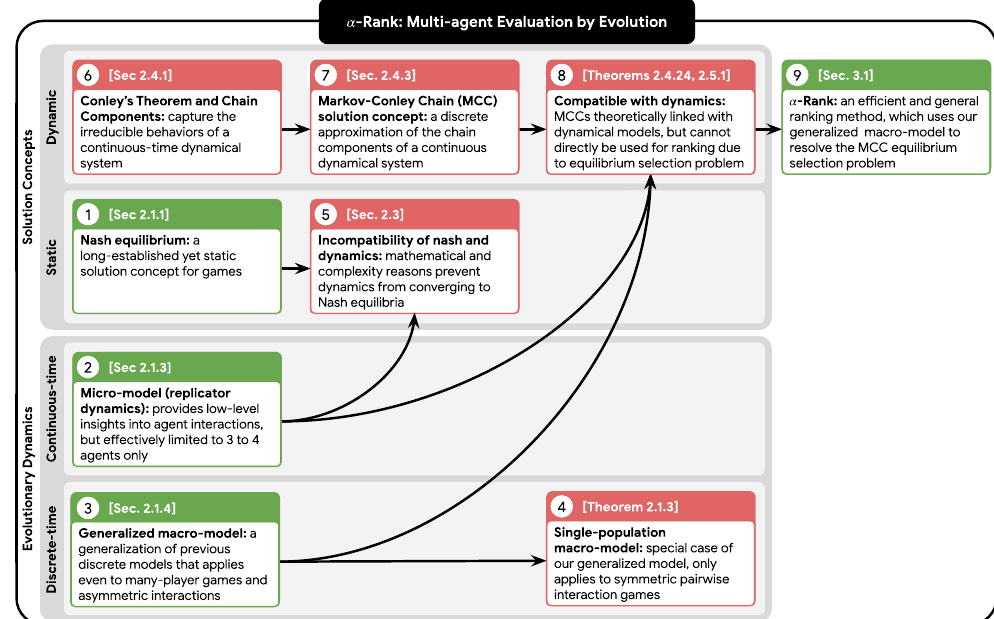
Figure 1. Paper at a glance. Numerical ordering of the concept boxes corresponds to the paper flow, with sections and/or theorems indicated where applicable. Due to the technical background necessary for fully understanding the paper contribution, we give readers the choice of a ‘short’ vs. ‘long’ read-through of the paper, with the short read-through consisting of the sections highlighted in green in this figure and suited for the reader who wants to quickly grasp the high-level ideas, and the long read-through consisting of all technical details. The methods and ideas used herein may be classified broadly as either game-theoretic solution concepts (namely, static or dynamic) and evolutionary dynamics concepts (namely, continuous- or discrete-time). The insights gained by analyzing existing concepts and developing new theoretical results carves a pathway to the novel combination of our general multi-agent evaluation method, α -Rank, and our game-theoretic solution concept, Markov-Conley